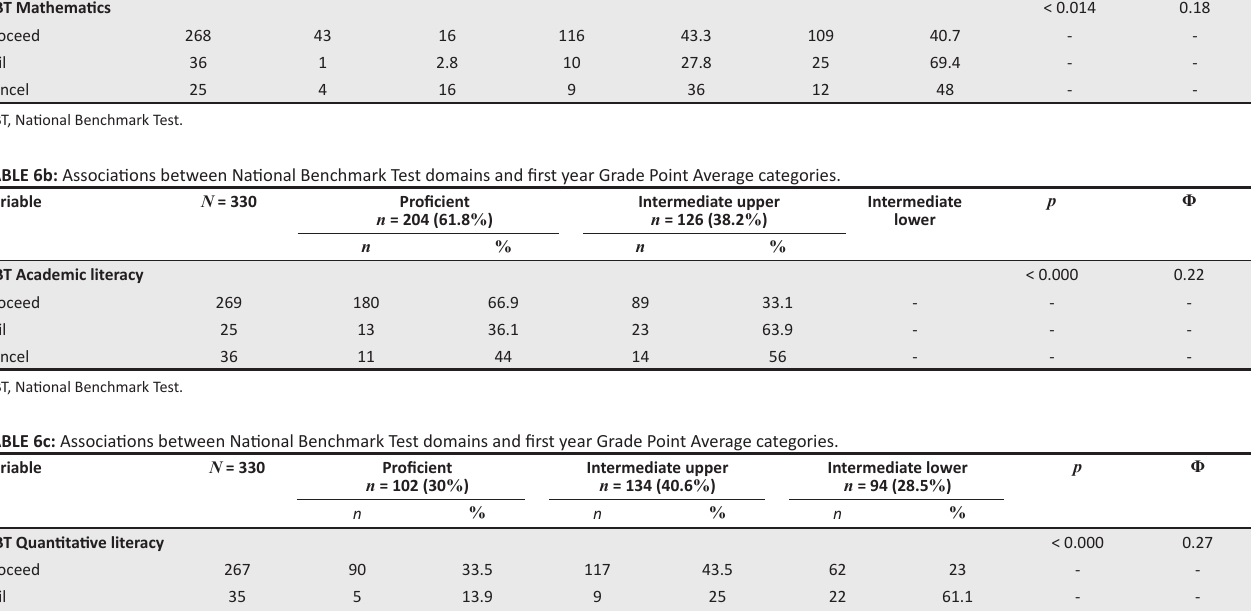
TABLE 6a: Associations between National Benchmark Test domains and first year Grade Point Average categories. Variable N = 329 Proficient n = 48 (14.6 % )